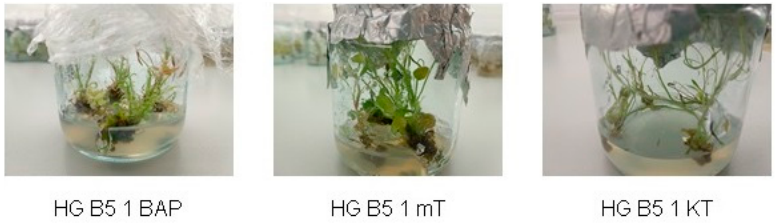
Figure 2. The effect of different types of growth regulators on plants of H. grandiflorum shoots in vitro .